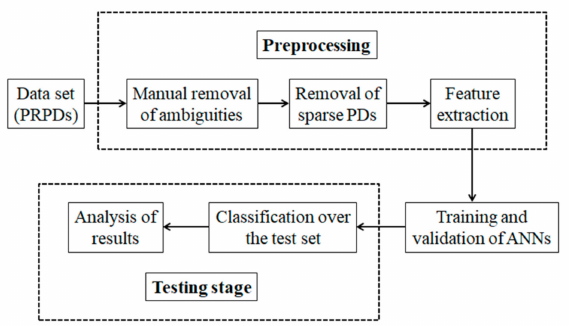
Figure 3. Flowchart of partial discharge signal recognition by artificial neural network.